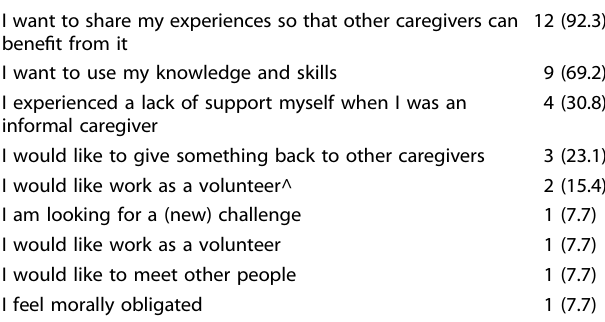
Table 3. Motivational reasons of former caregivers for sharing experiences with current caregivers ( N = 13).